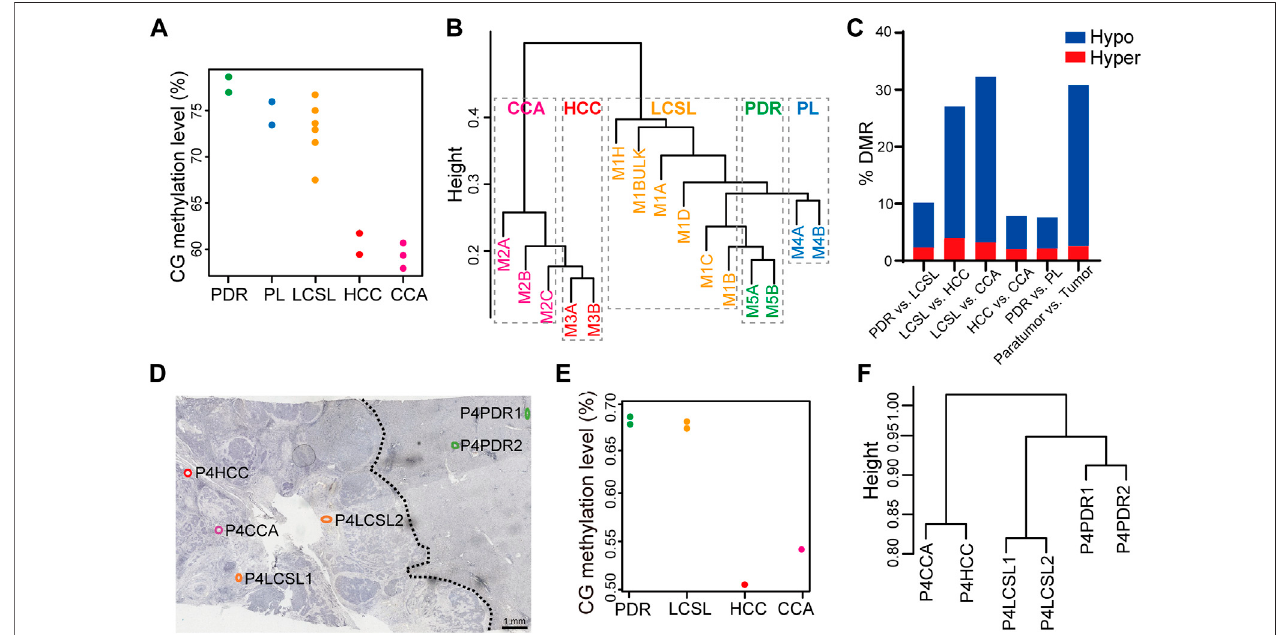
FIGURE3| SubstantiallyfewerDNAmethylationchangesinLCSLcellsthaninHCCandCCAcells. (A – C) WGBSanalysisofdifferentcellsamplesfromP2. (A) The globalDNAmethylationlevelof fi vedifferenttypesofcells.Eachdotrepresentsonesample. (B) ClusteranalysisoftheDNAmethylationpatternofallWGBSsamples. (C) DMR frequency between different cell types. (D – F) WGBS analysis of the FFPE HCC-CCA specimen P4. Different types of cells were captured from FFPE sections of specimenP4andWGBSwasperformedbyCIL-seq. (D) Locationsandnamesofthesamples.Thesectionwasimmunostainedwithanti-EpCAMbeforeLCM.The dotted lines in the fi gure indicate the boundaries between the tumor and the paratumor, which were determined by IHC staining and tissue/cell morphology under microscope. (E) The global DNA methylation levels ofsixdifferenttypes ofcells. Each dot representsonesample. (F) Cluster analysisoftheDNA methylationpatterns of all WGBS